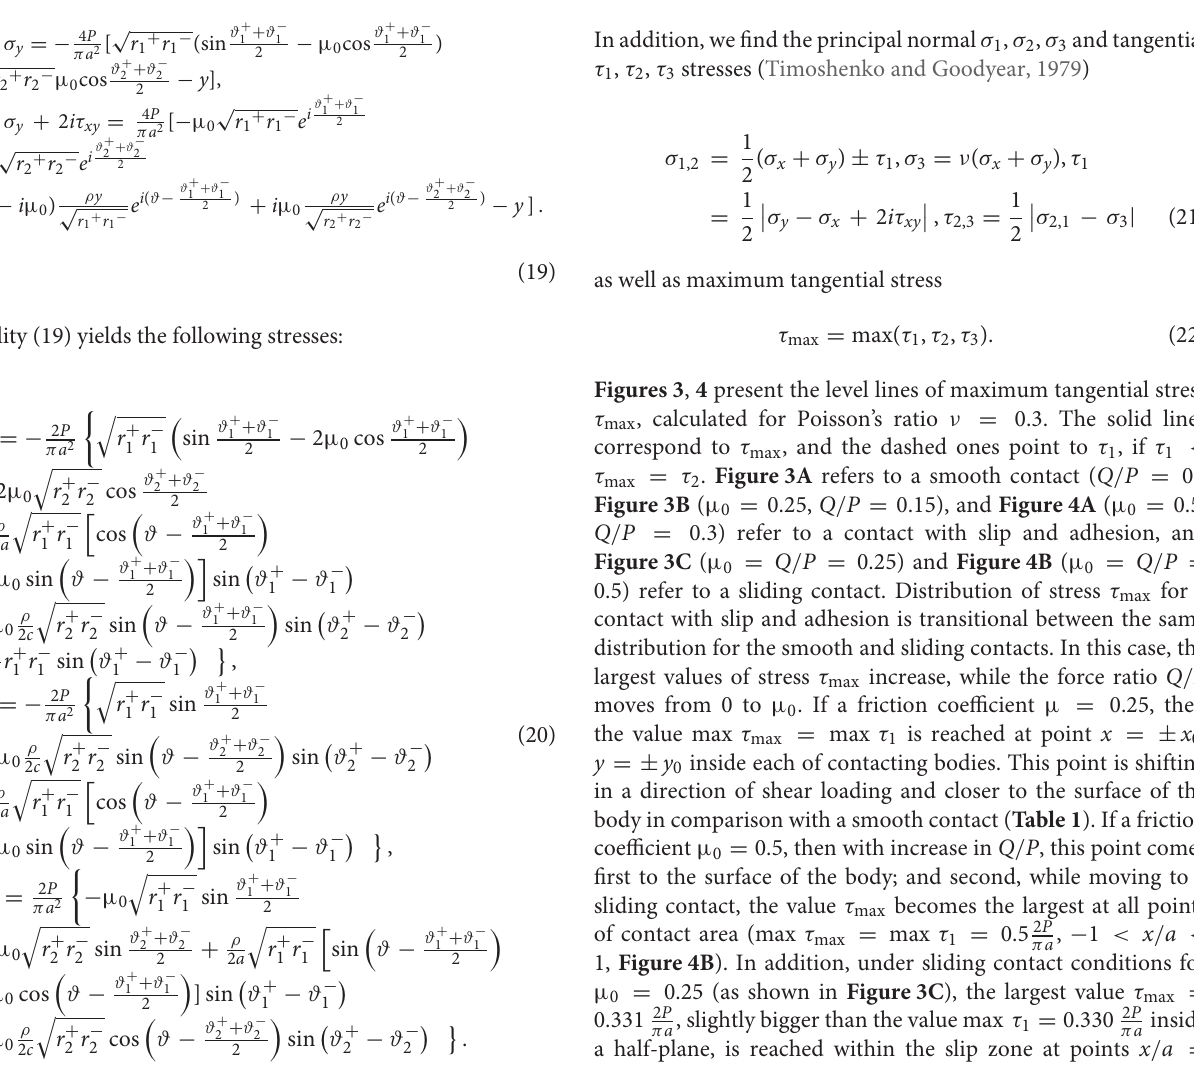
p ( x ) and tangential ¯